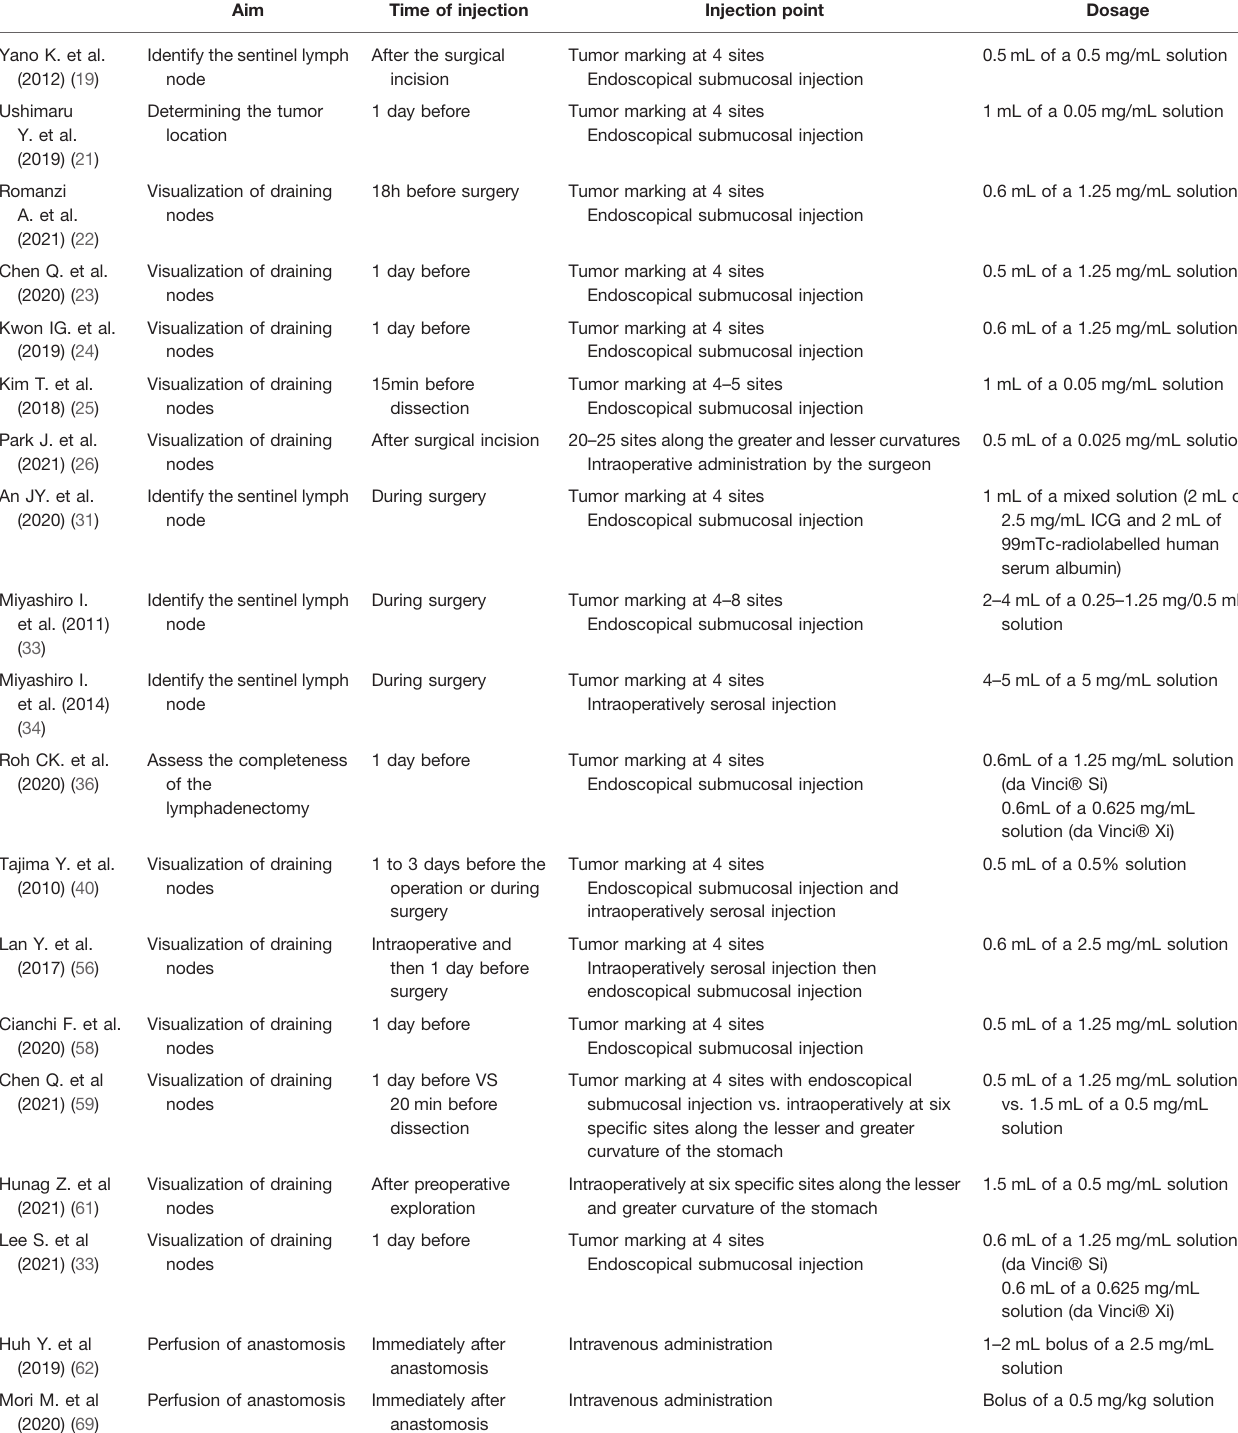
TABLE 1 | Summary of included